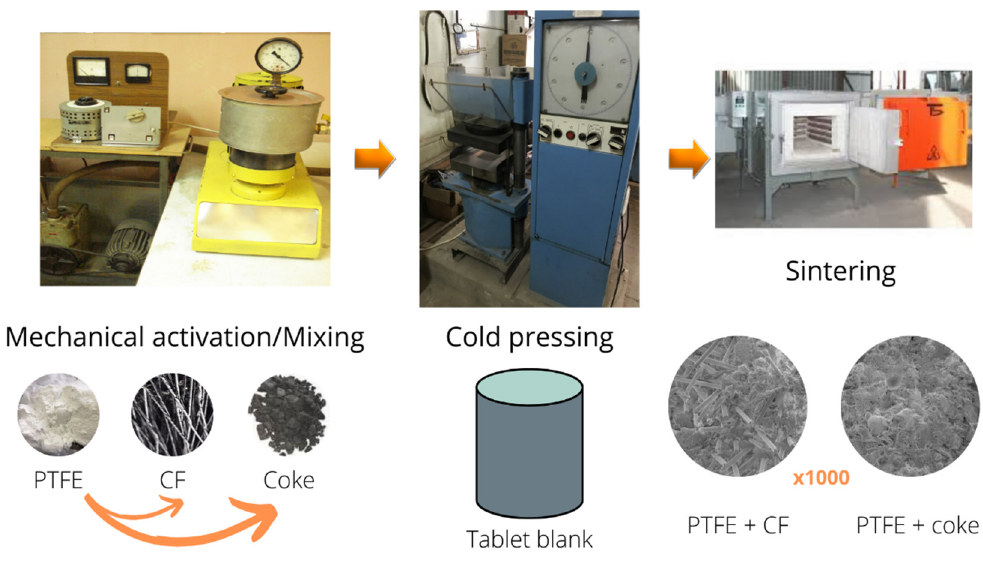
Figure 1. Scheme of step-by-step production technology of PTFE